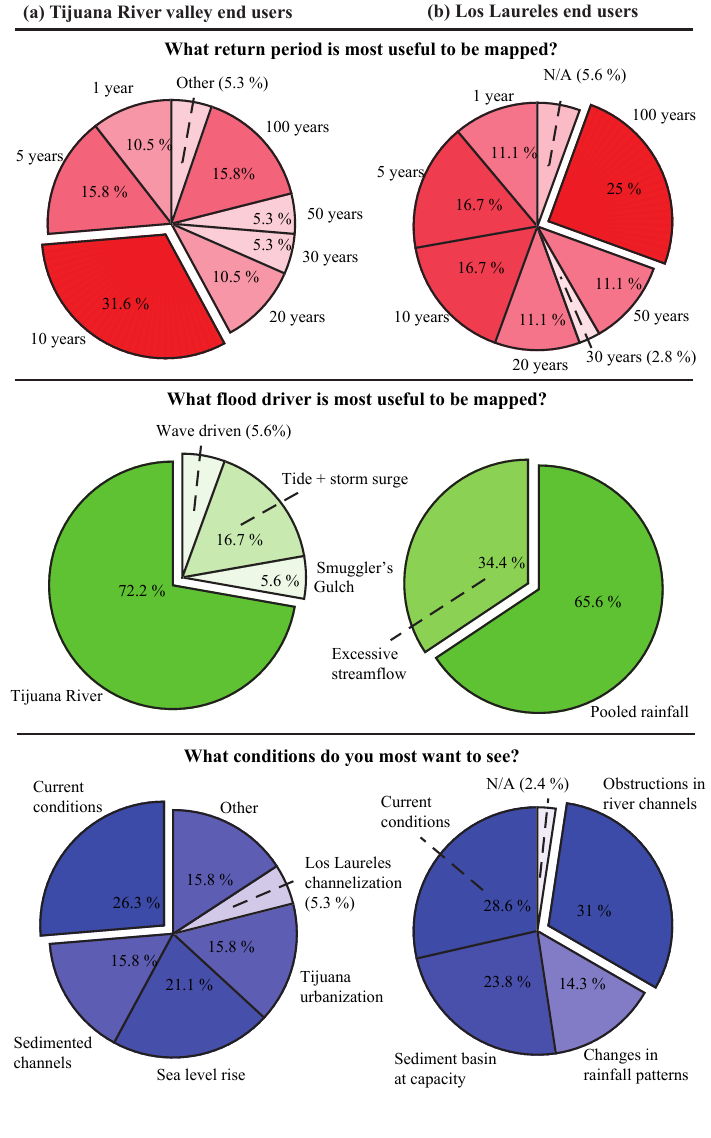
Figure 6. Results of the exit survey designed to provide insight on relevant flood frequencies, drivers, and environmental conditions. Column (a) includes TRV responses (22 participants), and column (b) includes LL responses (33 participants). The most distinct responses include the reported utility of maps illustrating more frequent events (TRV) and pooled rainfall (LL). The lack of a clear preference for relevant environmental conditions is worth noting. Here, “environmental conditions” are defined as the physical conditions of study area or the state of climate related variables during the simulated flood. Maps depicting possible impacts of climate change (e.g., sea level rise and changes in rainfall patterns) were not the most desired conditions for end users of either